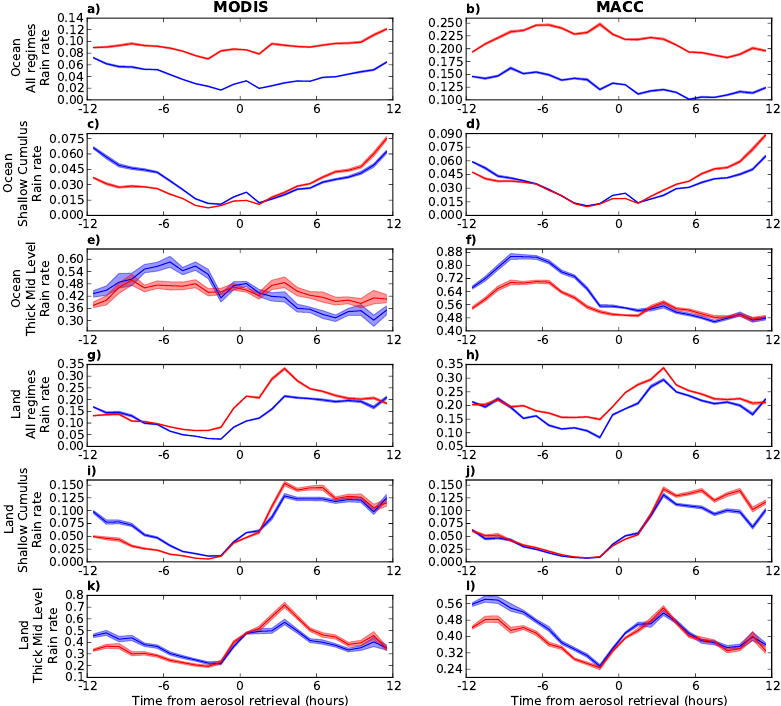
Figure 7. TRMM 3B42 precipitation development plots in the style of Gryspeerdt et al. (2014b) from 2003 to 2007 between 30 ◦ N and 30 ◦ S, comparing the use of MODIS AOD (left column) and MACC total AOD at 550nm (right column) as the aerosol product. This shows the development of the precipitation at times before and after the aerosol retrieval (13:30LST). The red line is the precipitation rate for the high AOD population and the blue for the low AOD population. Statistical errors are shown at the 95% level. The plots are shown for ocean (a – f) and land (g – l) separately. For each product and surface type, data for all the regimes together are shown along with the shallow cumulus regime (as an example of a low CF regime) and the thick mid-level regime (as an example of a high CF regime). The cloud regimes are only specified at the time of the aerosol retrieval; transitions may occur between regimes at other times. TRMM 3B42 merged precipitation is used throughout this